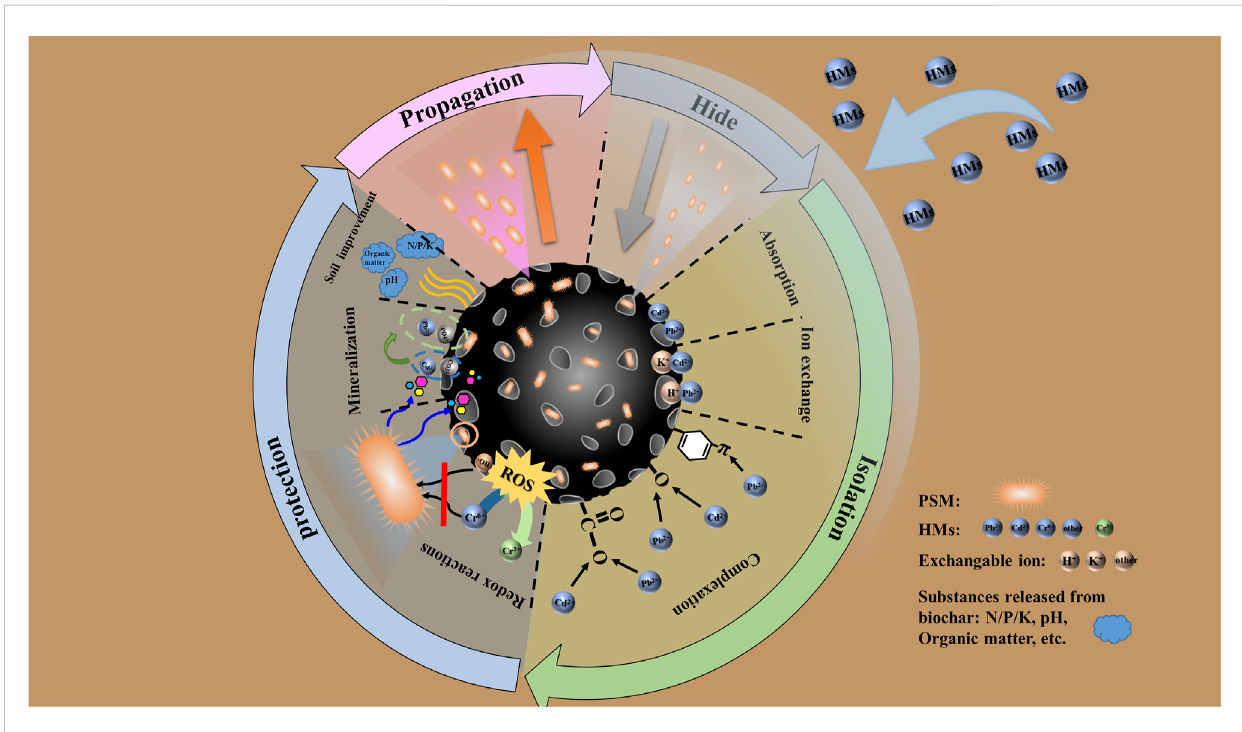
FIGURE 1 Schematic diagram of the mechanism of biochar-assisted phosphorus solubilizing microorganisms for remediation of heavy metals contamination in